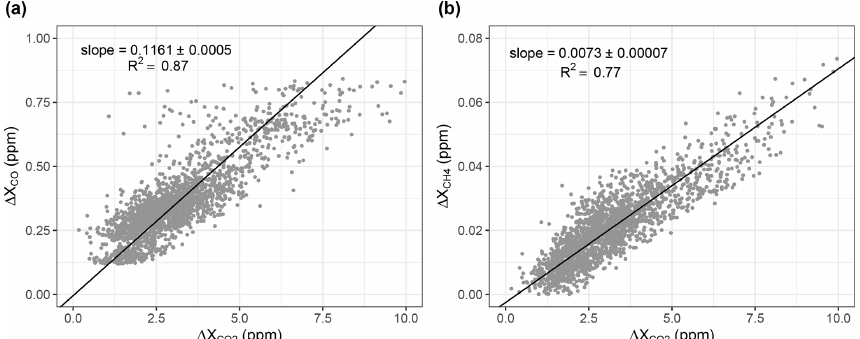
Figure 5. Relationship between (a) (cid:49) CO and (b) (cid:49) CH 4 against (cid:49) CO 2 during the SQF Complex wildfire plume on 12 September 2020.